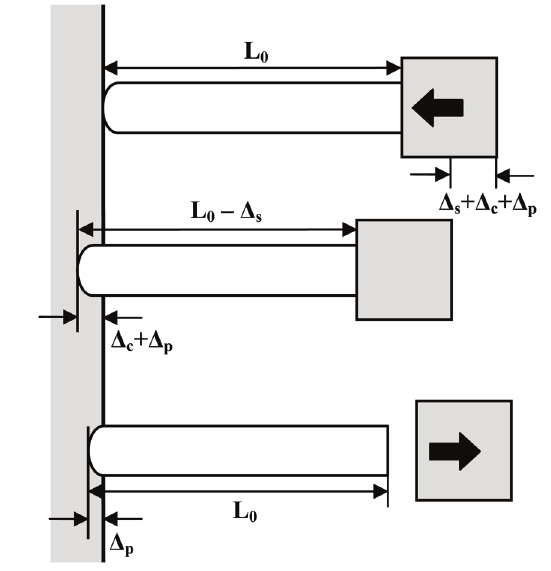
Fig. 1. Operating principle of the rebound